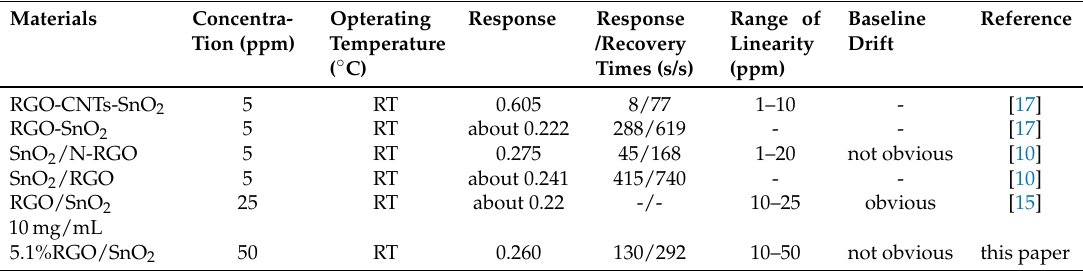
Table 2. Comparison of NO 2 sensing performances of our as-prepared sensor with other